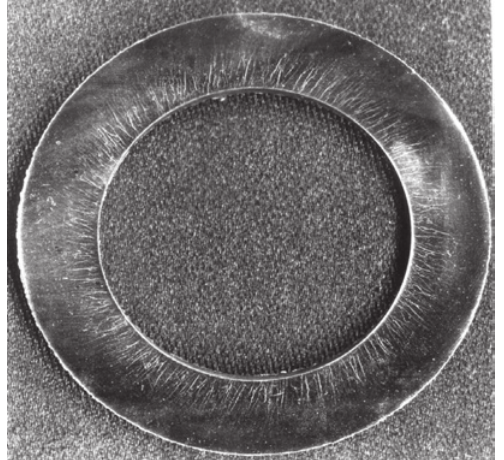
Fig. 13: Typical damage distribution in a reformer catalyst tube, HK40 material